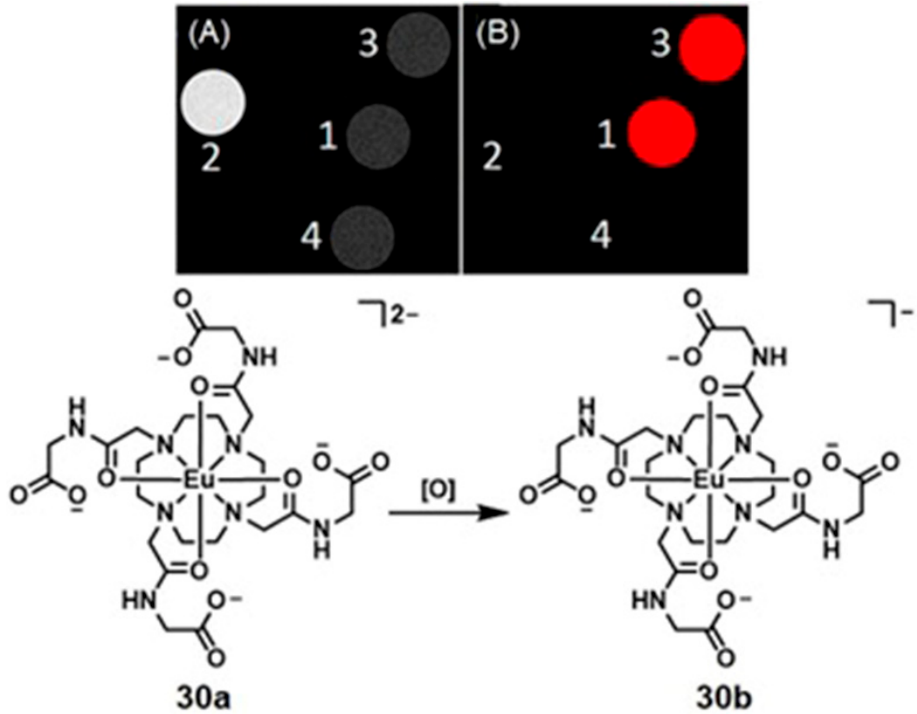
Figure 70. Images of ( A ) T 1 -weighted MRI and ( B ) CEST difference (55 ppm image subtracted from the –55 ppm image) of 5 mm diameter tubes containing (1) 30b , (2) 30a , (3) 30b after oxidation of 30a , and (4) water. Adapted with permission from Ekanger, L. A.; Mills, D. R.; Ali, M. M.; Polin, L. A.; Shen, Y.; Haacke, E. M.; Allen, M. J. Spectroscopic characterization of the 3+ and 2+ oxidation states of europium in a macrocyclic tetraglycinate complex. Inorg. Chem. , 2016 , 55 , 9981–9988. Copyright 2016 American Chemical Society [398].